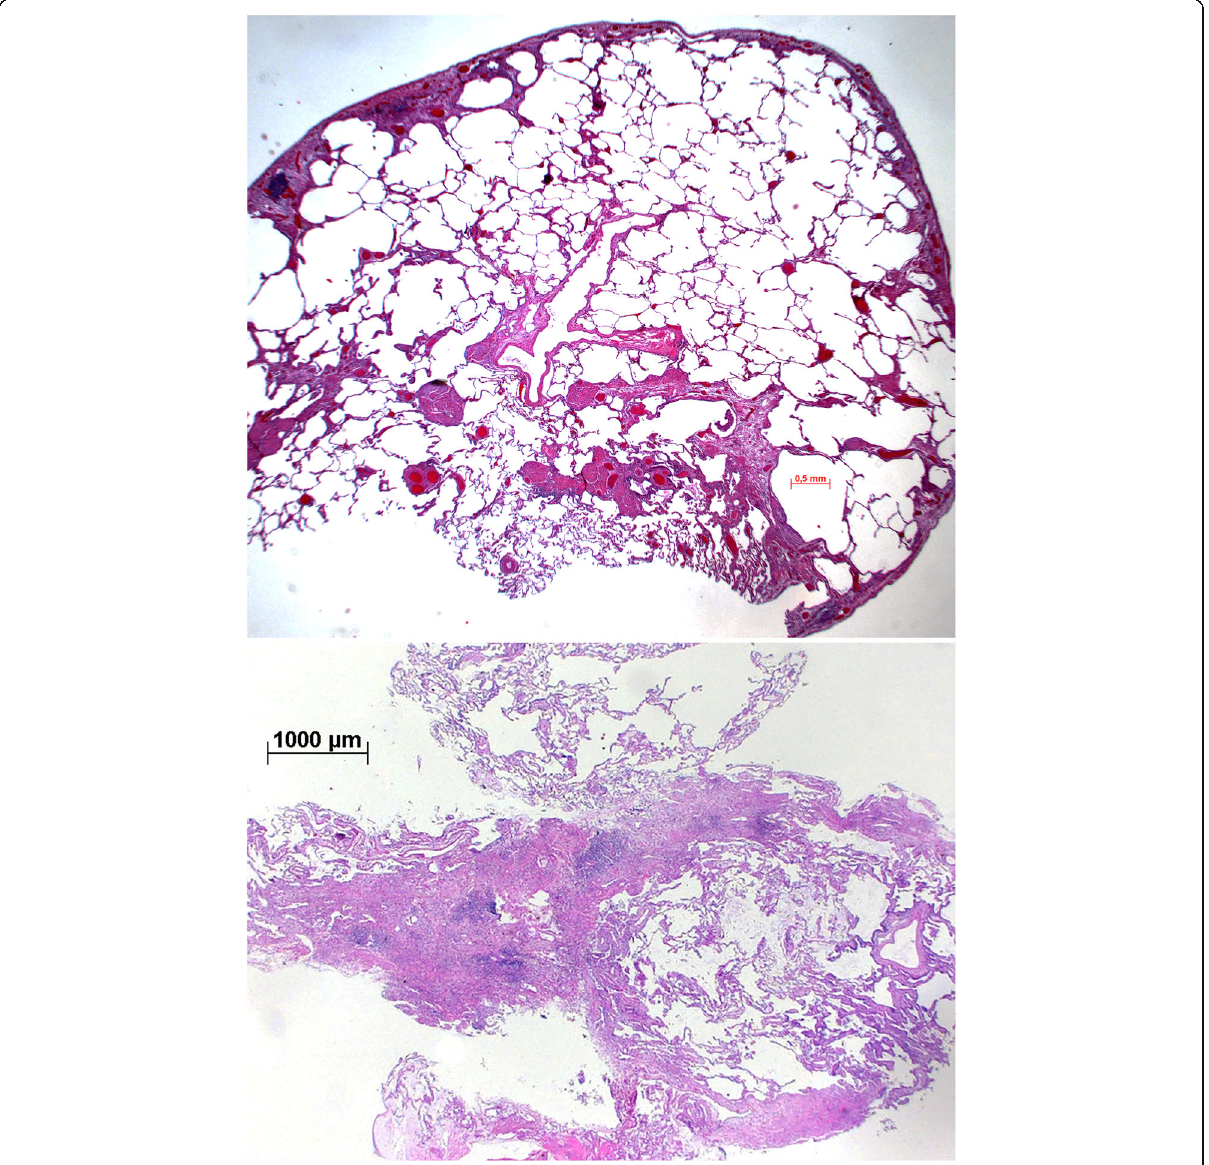
Fig. 1 Overview of UIP/IPF. The upper figure demonstrates the peripheral distribution of fibrosis. There is a lot normal lung visible. In the lower figure there is more fibrosis, also normal lung (heterogeneity), and lymphocyte aggregates around the cystic structures. H&E, bars 500 and 1000 μ